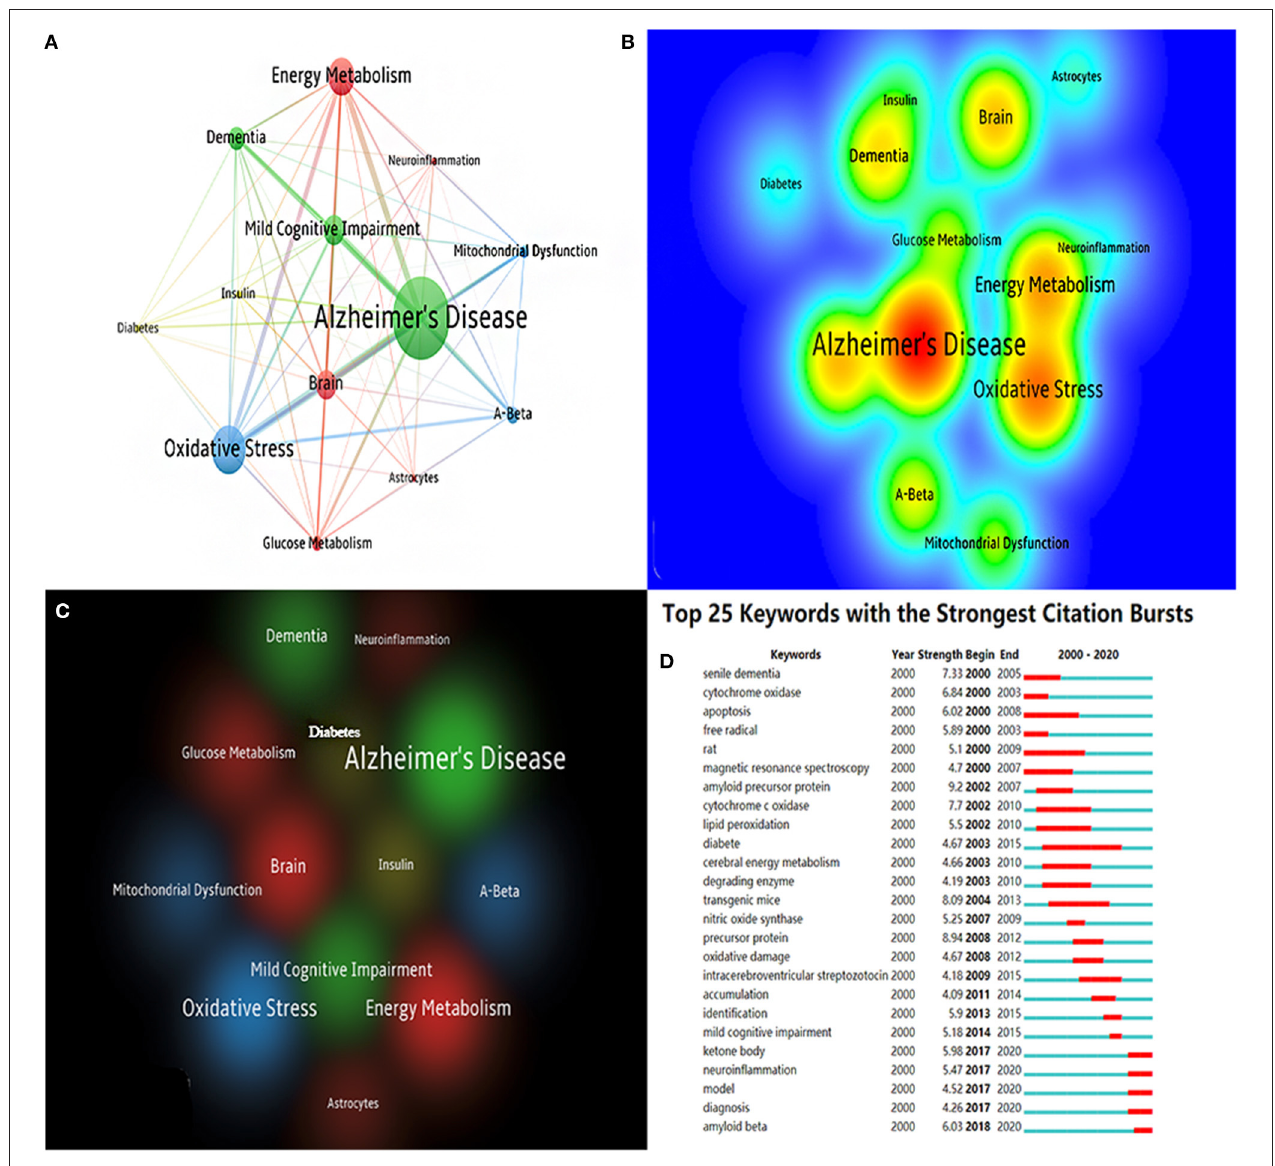
FIGURE 7 | (A) The co-citation network visualization map of keywords based on VOSviewer; (B) The density visualization map of keywords based on VOSviewer; (C) The cluster visualization map of keywords based on VOSviewer; (D) The top 25 keywords with the strongest citation bursts based on CiteSpace, The red horizontal stripes represent the years with the most frequent keyword use. The green horizontal stripes represent the years with the most infrequent keyword